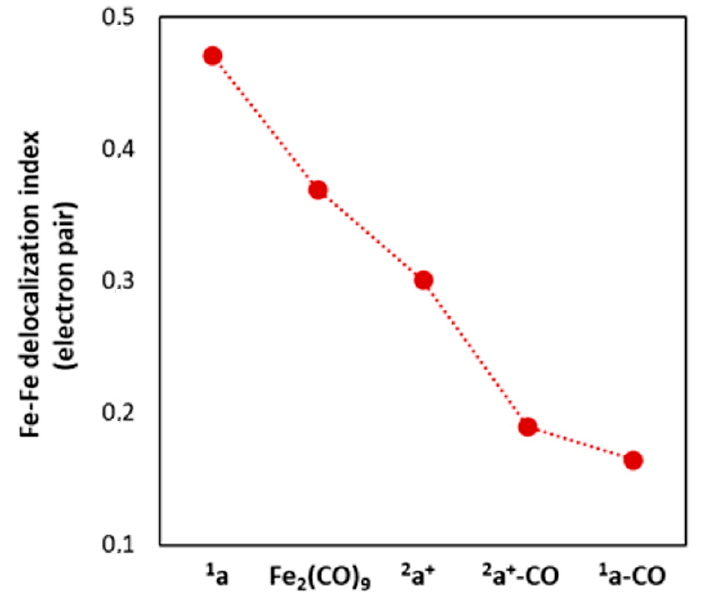
Figure 3. Values of the quantum theory of atoms in molecules (QTAIM) δ (Fe,Fe) delocalization index (in electron pair).